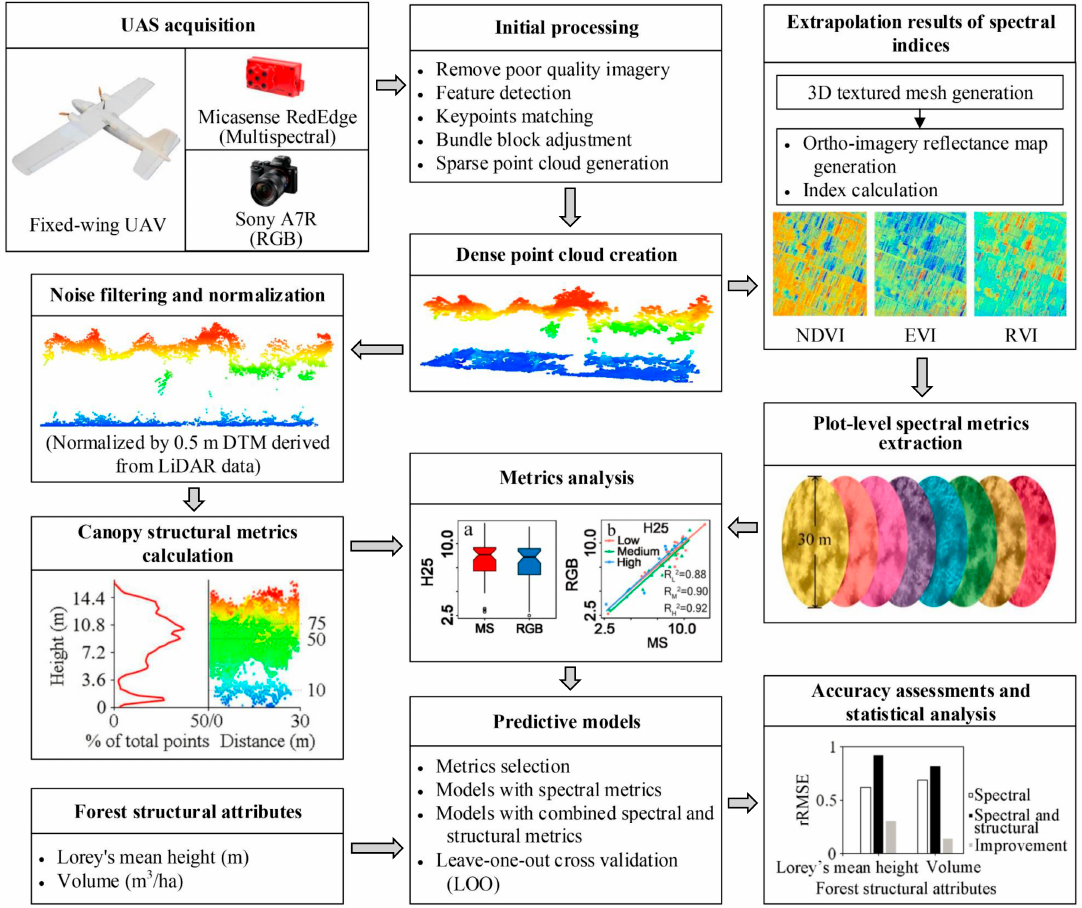
Figure 1. The workflow used to acquire unmanned aircraft system (UAS) imagery, generate the ortho-imagery index map and digital aerial photogrammetry point cloud data, extract spectral and structural metrics, and fit forest structural attributes models. NDVI: Normalized Difference Vegetation Index; EVI: Enhanced Vegetation Index; RVI: Ratio Vegetation Index; DTM: Digital Terrain Model; H25: 25th percentile of the canopy height distributions; rRMSE: relative Root-Mean-Square-Error.